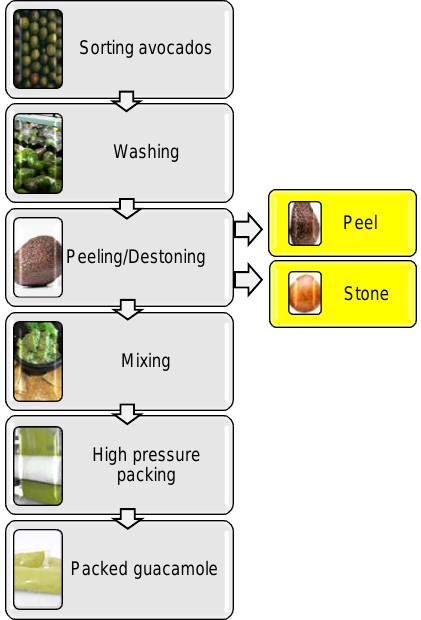
Figure 5. The guacamole process and by-products/waste generated (yellow squares).